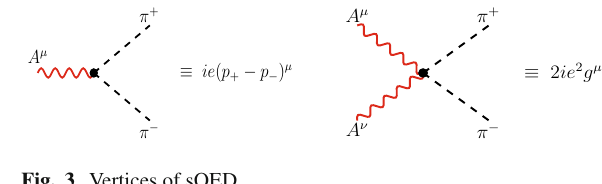
Fig. 3 Vertices of sQED